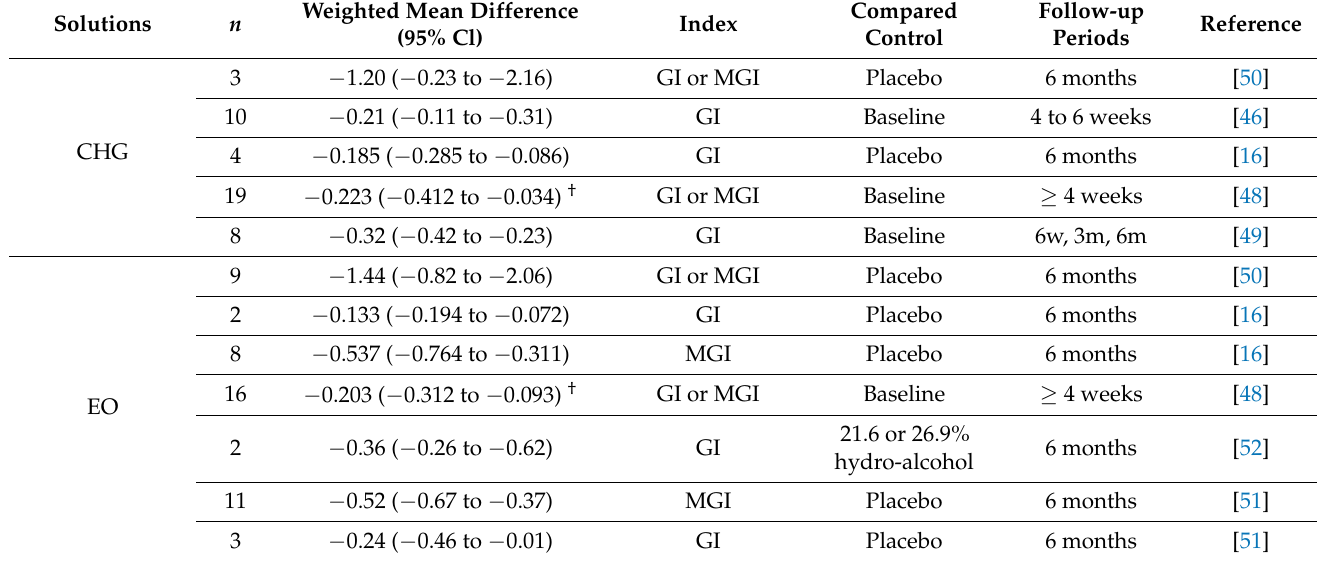
Table 3. Summary for the reduction of gingival